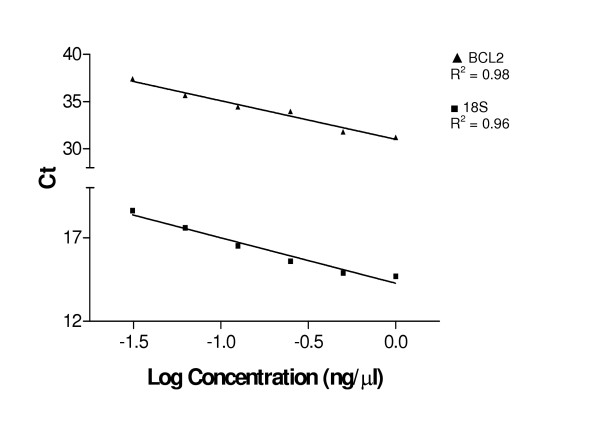
Measurement by LDA of mRNA's for two genes (BCL2 and 18S) derived from a 2-fold dilution series of liver cDNA. Each data point represents the mean Ct (copy threshold) value derived from quadruplicate measurement of each sample dilution. A line of best fit and R2 value were derived using PRISM software.